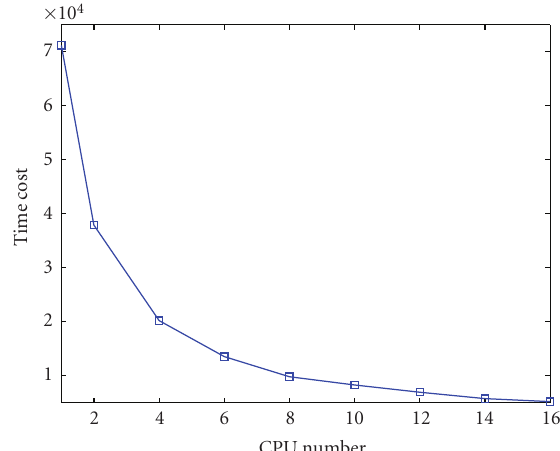
Figure 7: Performance comparison depending on CPU number.